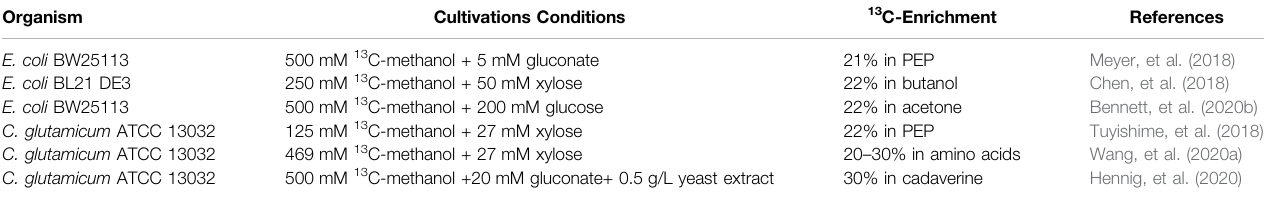
TABLE 1 | Overview of 13 C-methanol incorporation level at the intracellular level or in fi nal products in strains after ALE experiment.